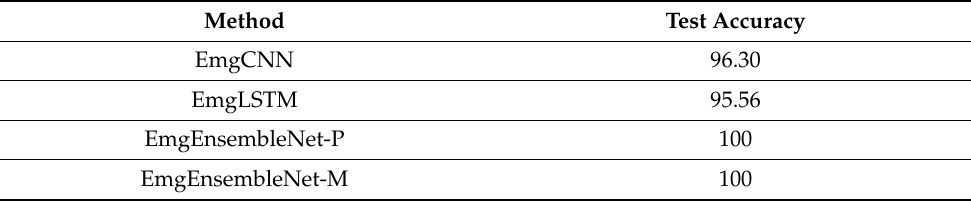
Table 7. Verification Accuracies on Test data of CU-EMG-ECG